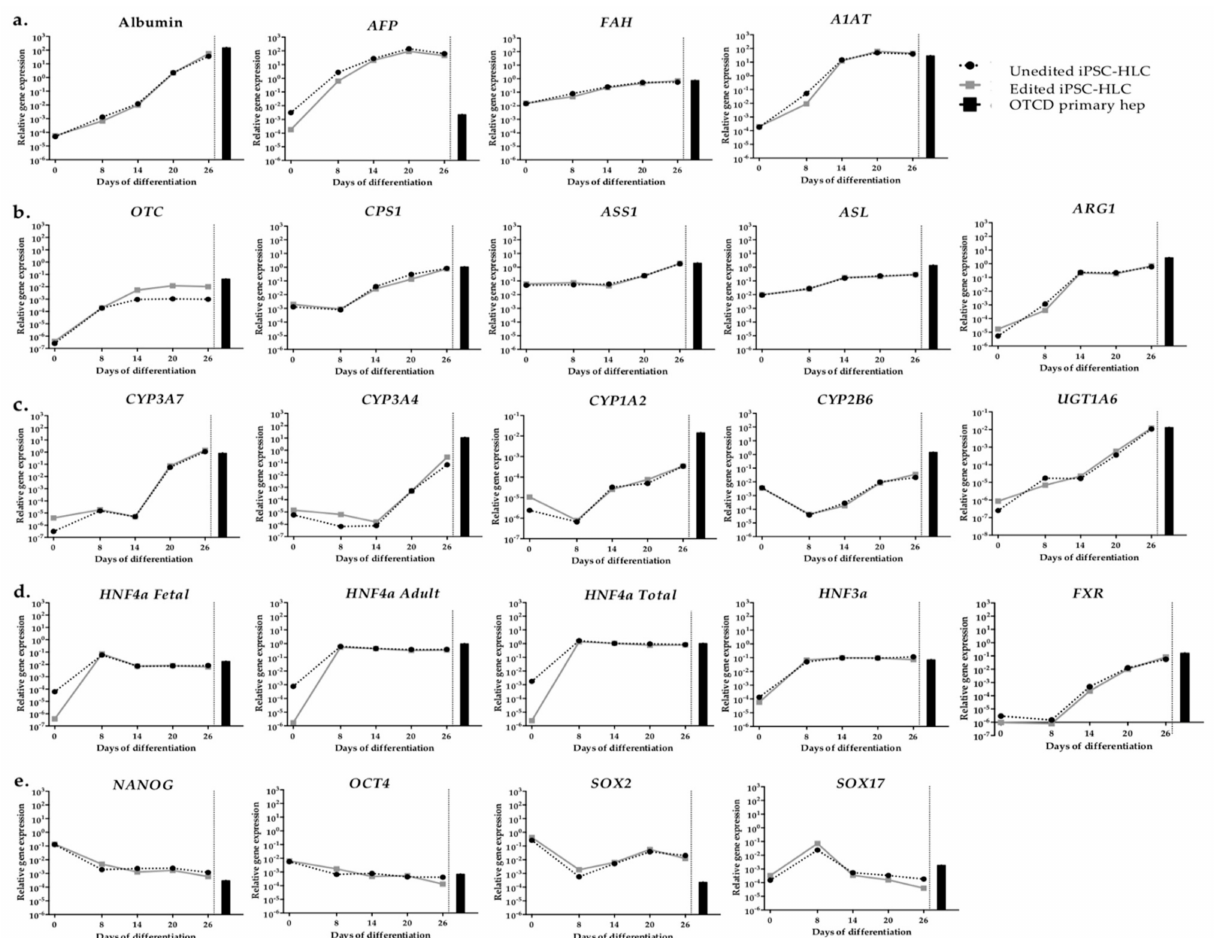
Figure 5. Gene expression profiling of organoid iPSC hepatocyte-like cells (HLC) organoids. Expression of genes for liver-specific plasma proteins and metabolic enzymes ( a ), urea cycle proteins ( b ), phase I and II conjugation proteins ( c ), transcription factors ( d ) and pluripotency genes ( e ) was measured at different time points of differentiation protocol. Dashed and continuous lines show unedited and edited iPSC-HLC organoids, respectively. Black bar indicates the level of expression of the respective gene in primary OTCD hepatocytes from the same patient. Expression levels were normalized to endogenous gene ( PPIA ). Technical replicates n =